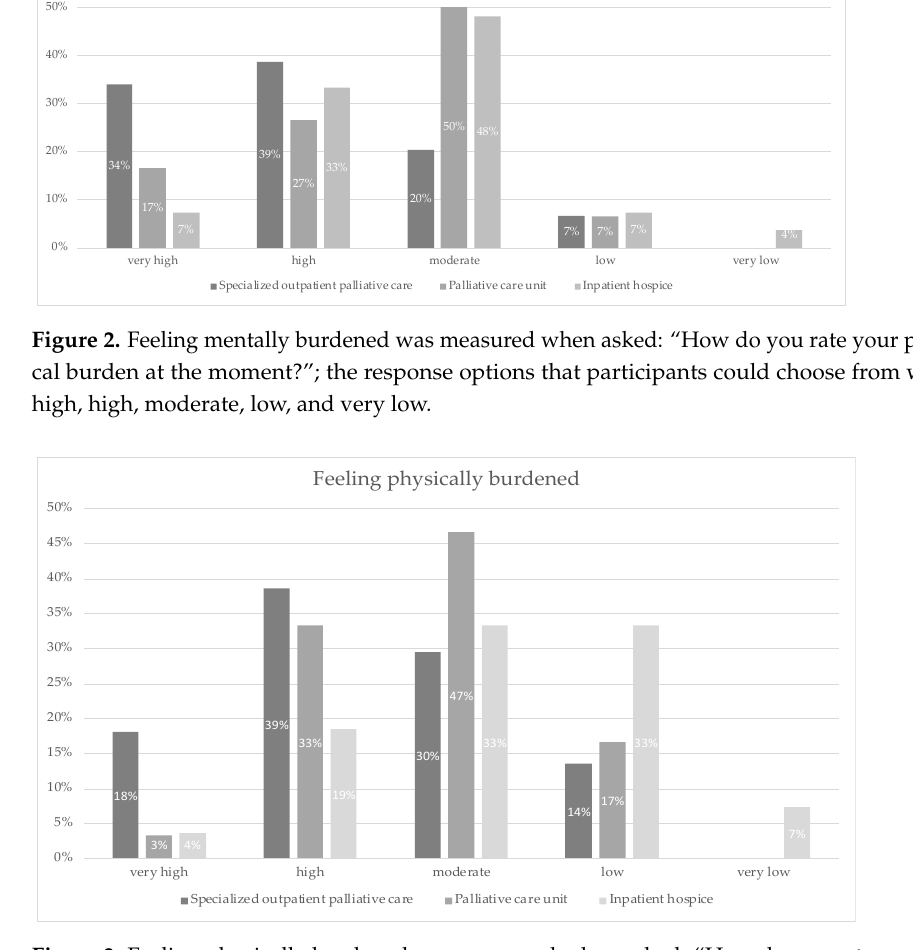
Figure 3. Feeling physically burdened was measured when asked: “How do you rate your physical burden at the moment?”; the response options that participants could choose from were: very high, high, moderate, low and very low.